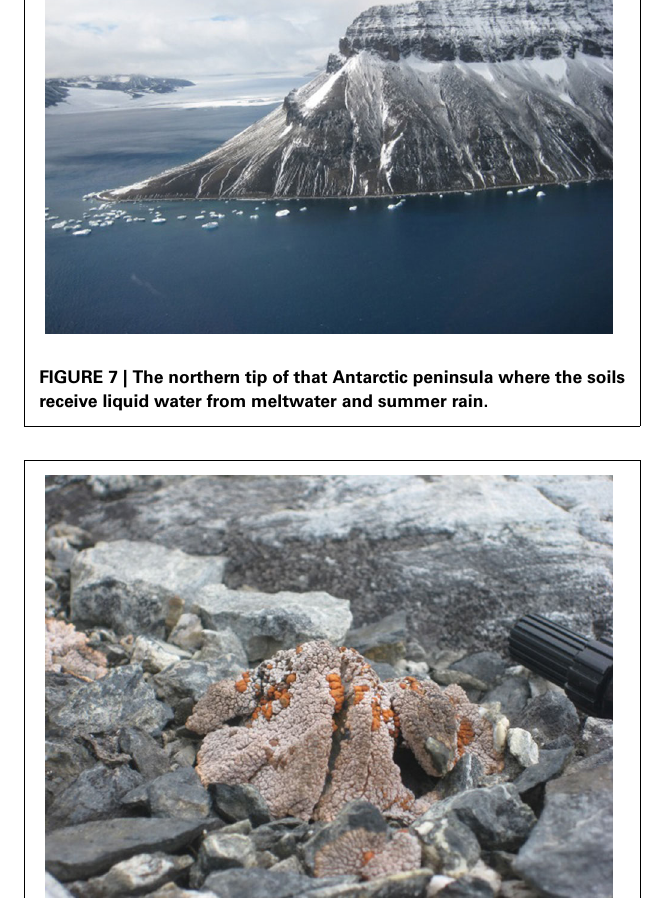
hyper-arid soils (Pointing et al., 2009; Rao et al., 2012). The iden- tification, in soil samples from the inland McKelvey Valley, of only 7 fungal phylotypes, two of which were affiliated to known genera ( Helicodendron and Zalerion ), suggests that free-living fungi